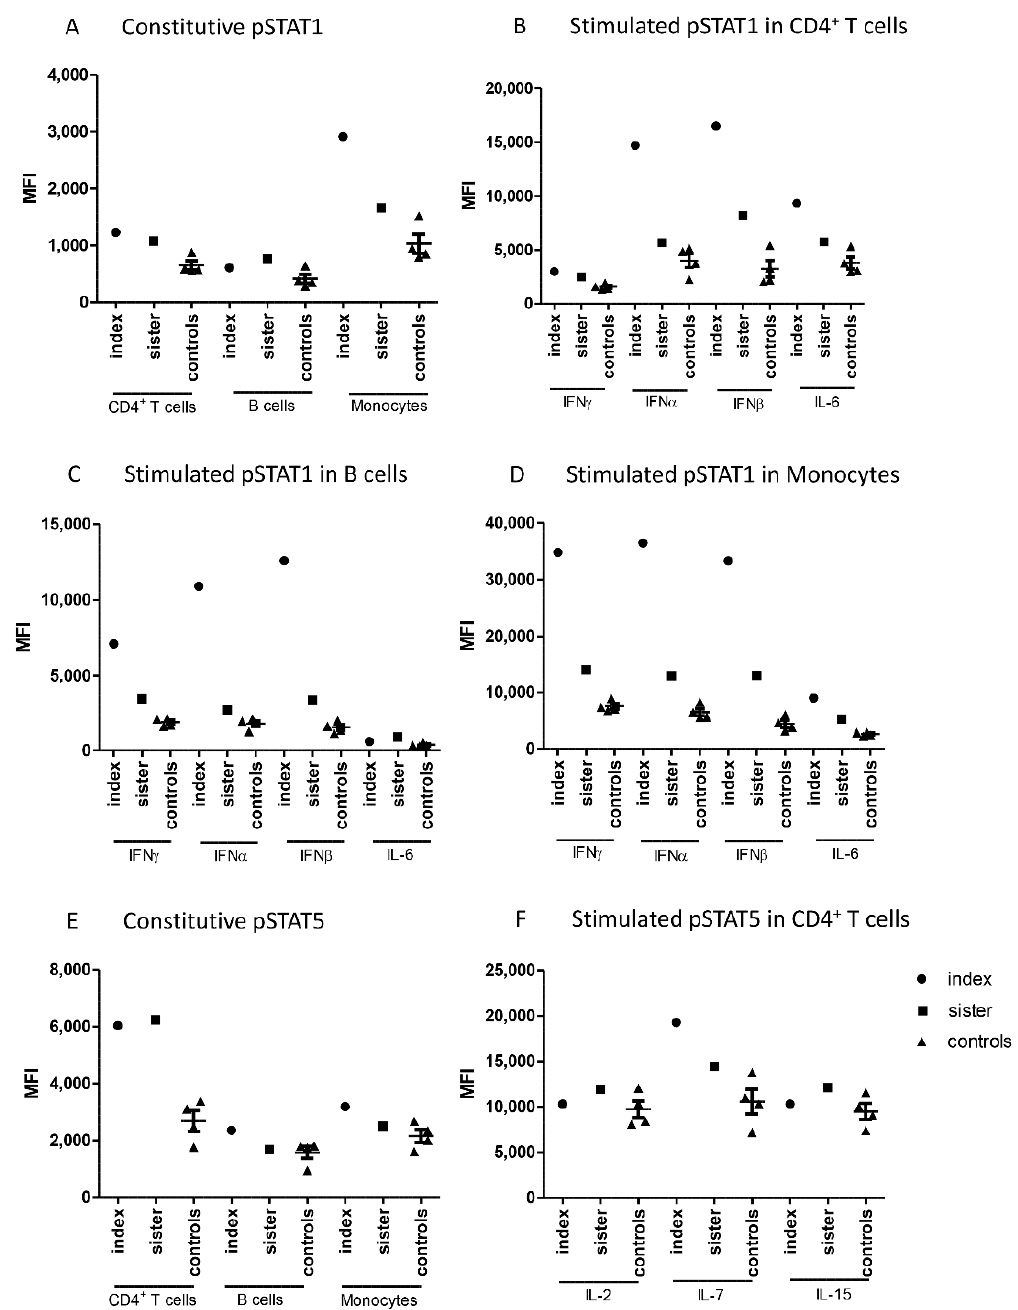
Figure 1. Median fluorescence intensities (MFI) measured in cells from patients and control subjects by flow cytometry for ( A ) Constitutive pSTAT1 in CD4 + T cells, B cells, and monocytes, ( B ) Stimulated pSTAT1 in CD4 + T cells, ( C ) Stimulated pSTAT1 in B cells, ( D ) Stimulated pSTAT1 in monocytes, ( E ) Constitutive pSTAT5 in CD4 + T cells, B cells, and monocytes ( F ) Stimulated pSTAT5 in CD4 + T cells. IFN; interferon, IL; interleukin, MFI; median fluorescence intensity, STAT; signal transducer and activator of transcription.